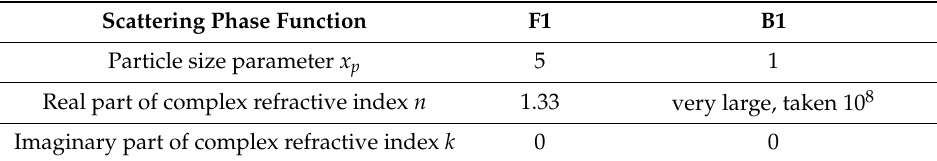
Table 1. Data for evaluation of the scattering phase functions by Mie equations.